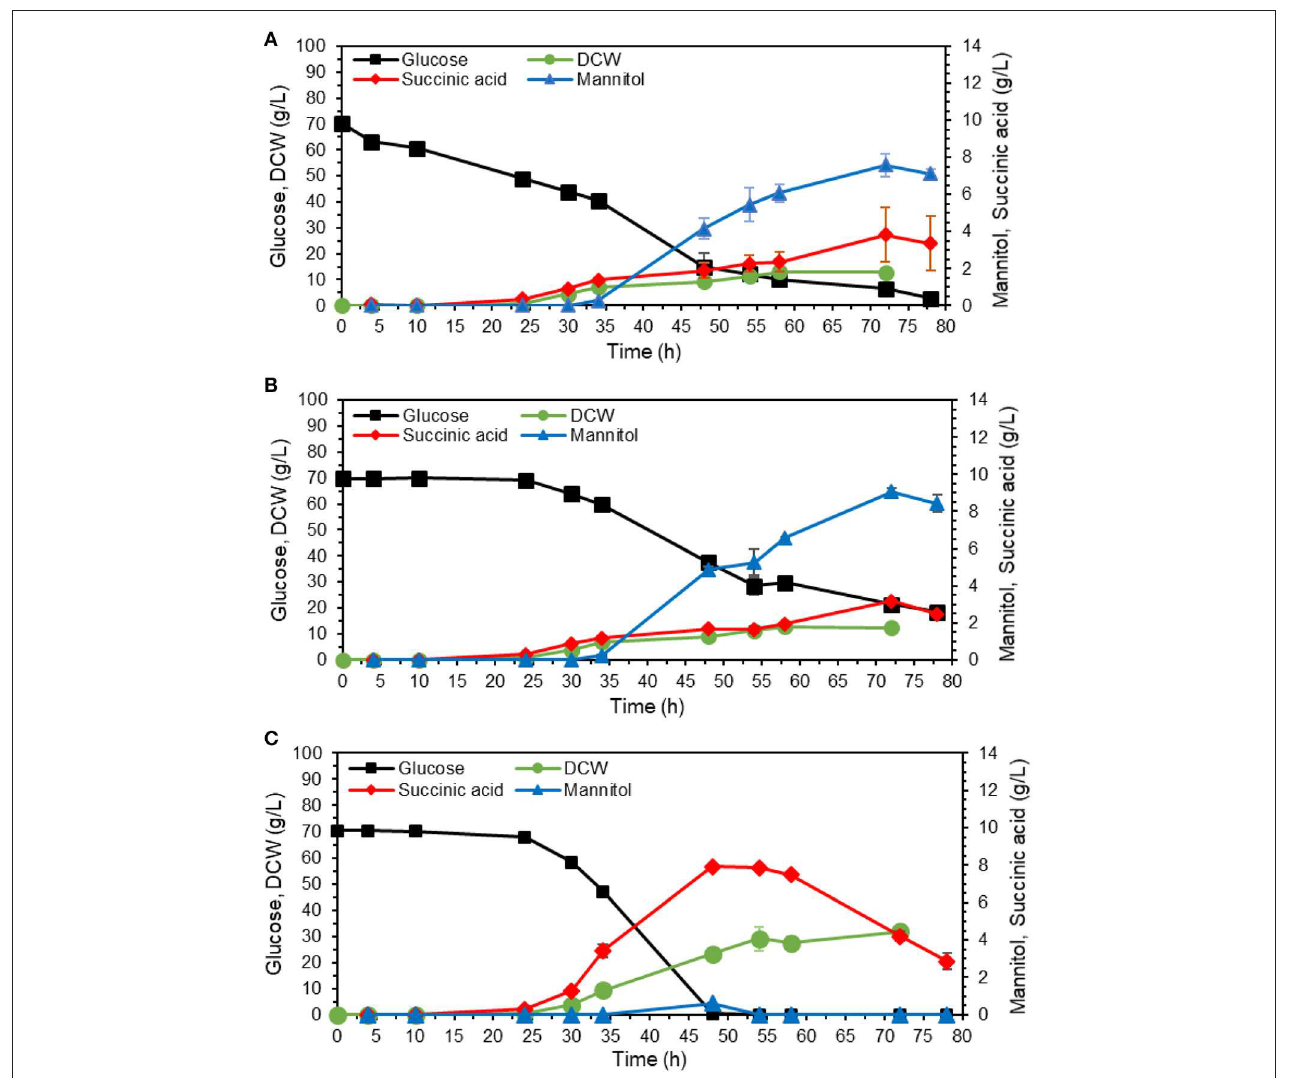
FIGURE 6 | Effect of aeration rate and medium buffering on mannitol production. The adapted isolate 54 was cultivated in shake flasks on YP with 70 g/L glucose. (A) Cultivation volume was 20% of the total flask volume. (B) Cultivation volume was 10% of the total flask volume to obtain better aeration. (C) Cultivation volume was as in A, medium was buffered with 10 g/L calcium carbonate. The values are averages from three biological replicates, the error bars show the standard deviation.